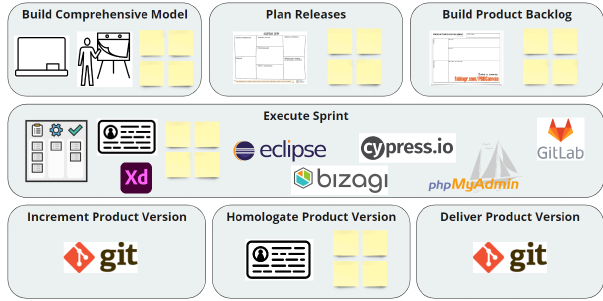
Figure 1. Software process before pandemic – Case 1